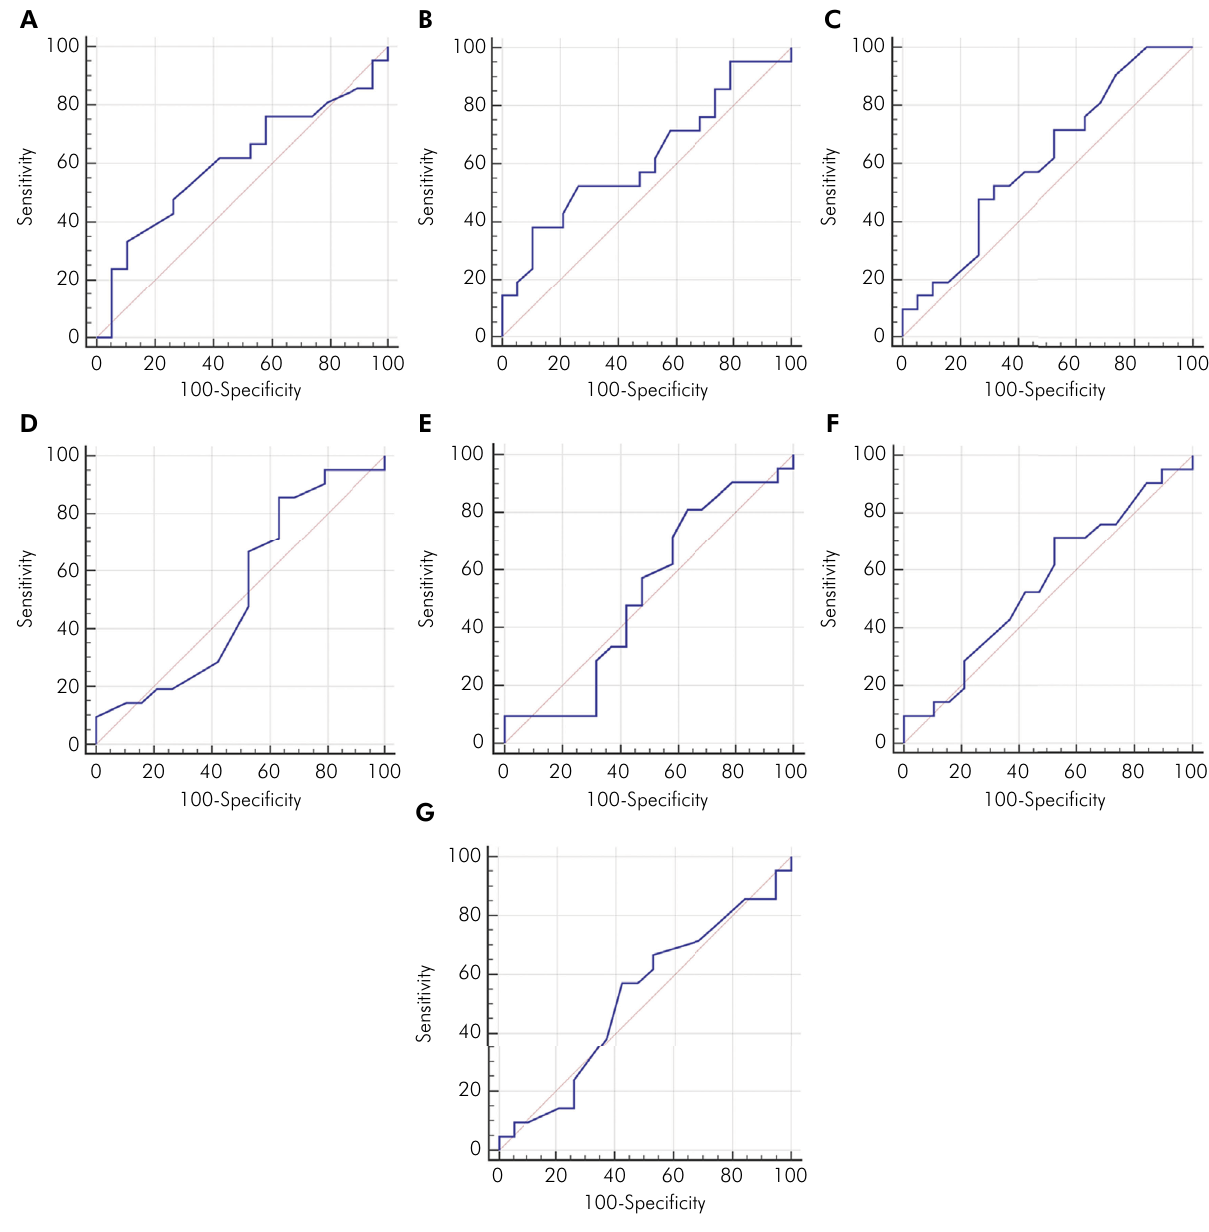
Figure 6. Graphs representing the receiver operator characteristic (ROC) of the posterior (A) , molar (B) , anterior (C) , symphysis (D) , computed tomography mandibular index (E) , computed tomography index (inferior) (F) , and computed tomography index (superior) (G)